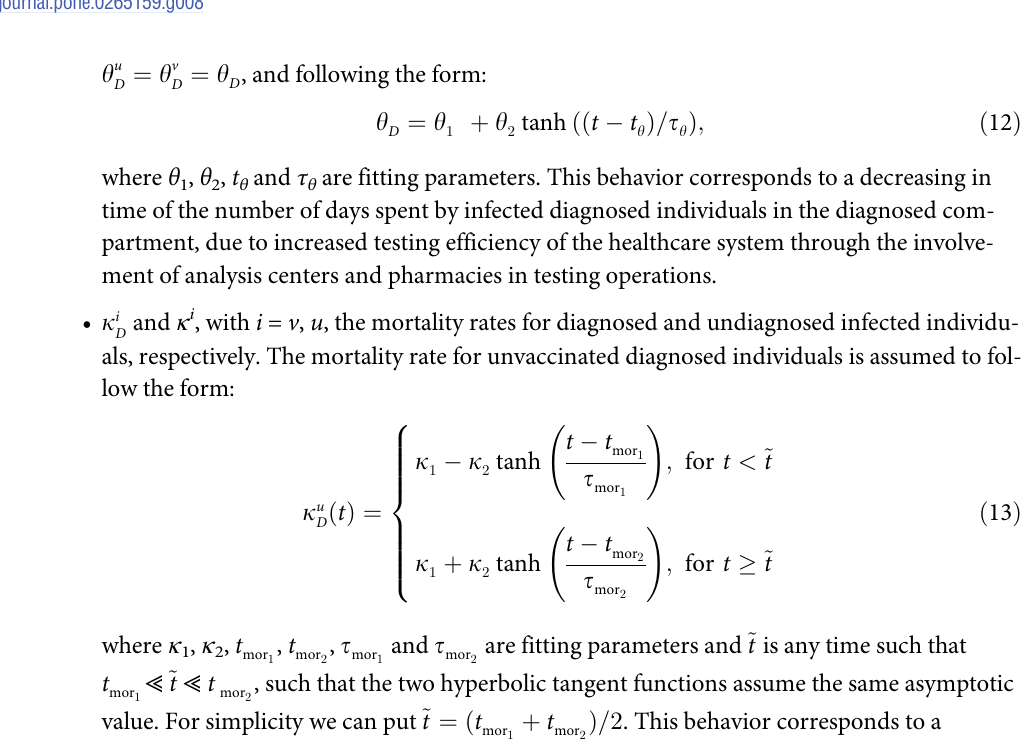
Fig 8. Best fit of vaccinated individuals. χ j ( j = 1, 2, 3) in Eq (1) are step functions suitably chosen to reproduce real data.